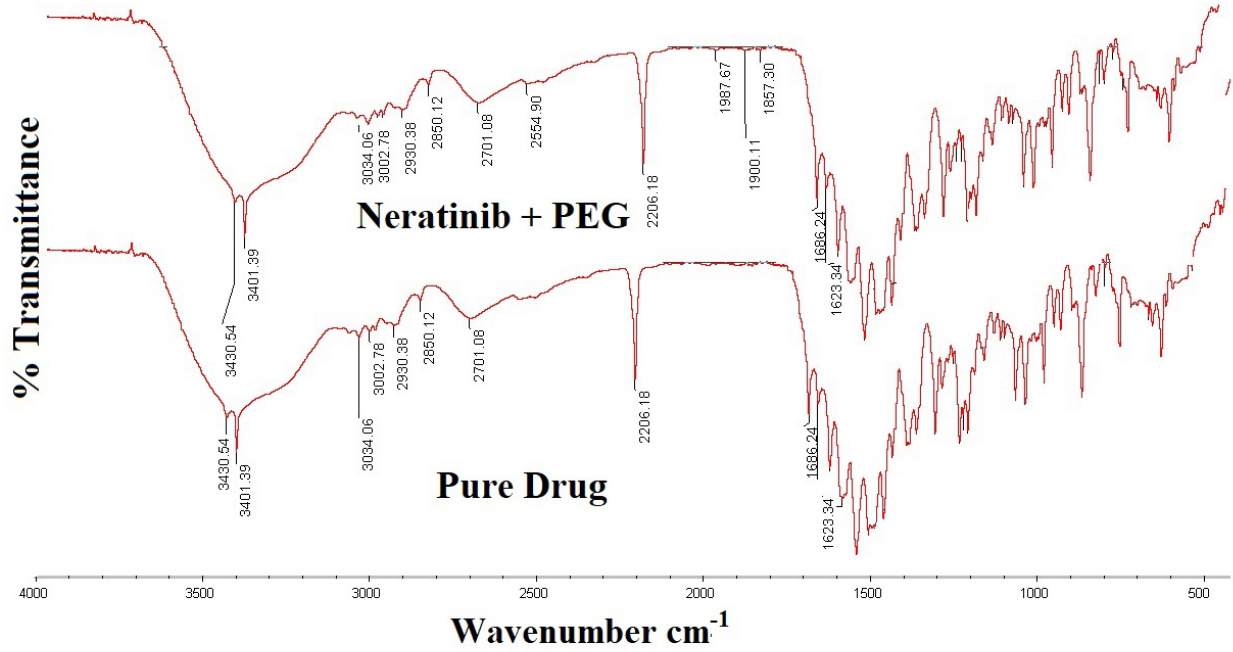
Figure 1. Overlain FT-IR spectra of pure drug neratinib and neratinib–PEG solid